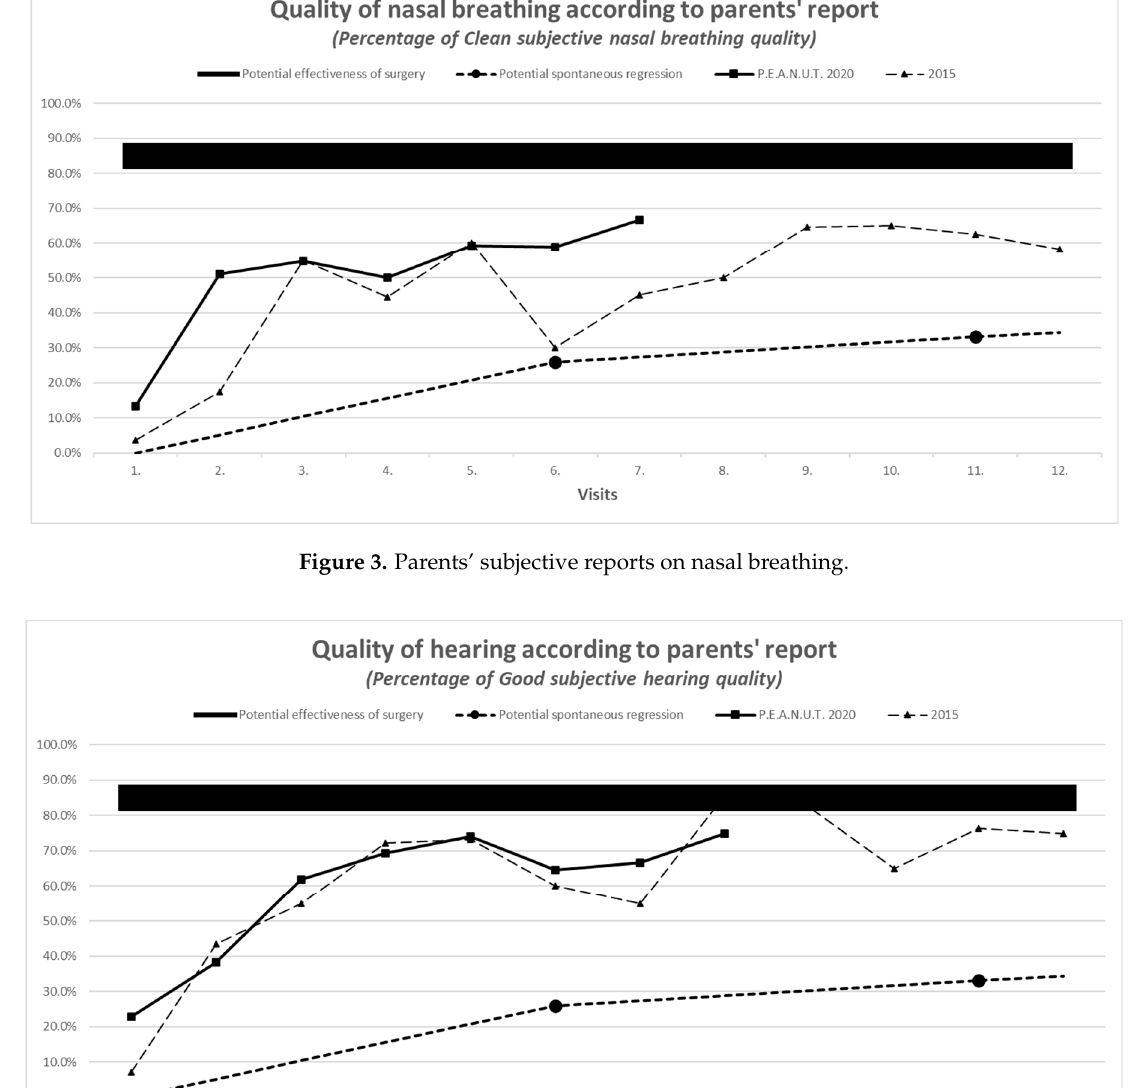
Figure 4. Parents’ subjective reports on hearing.